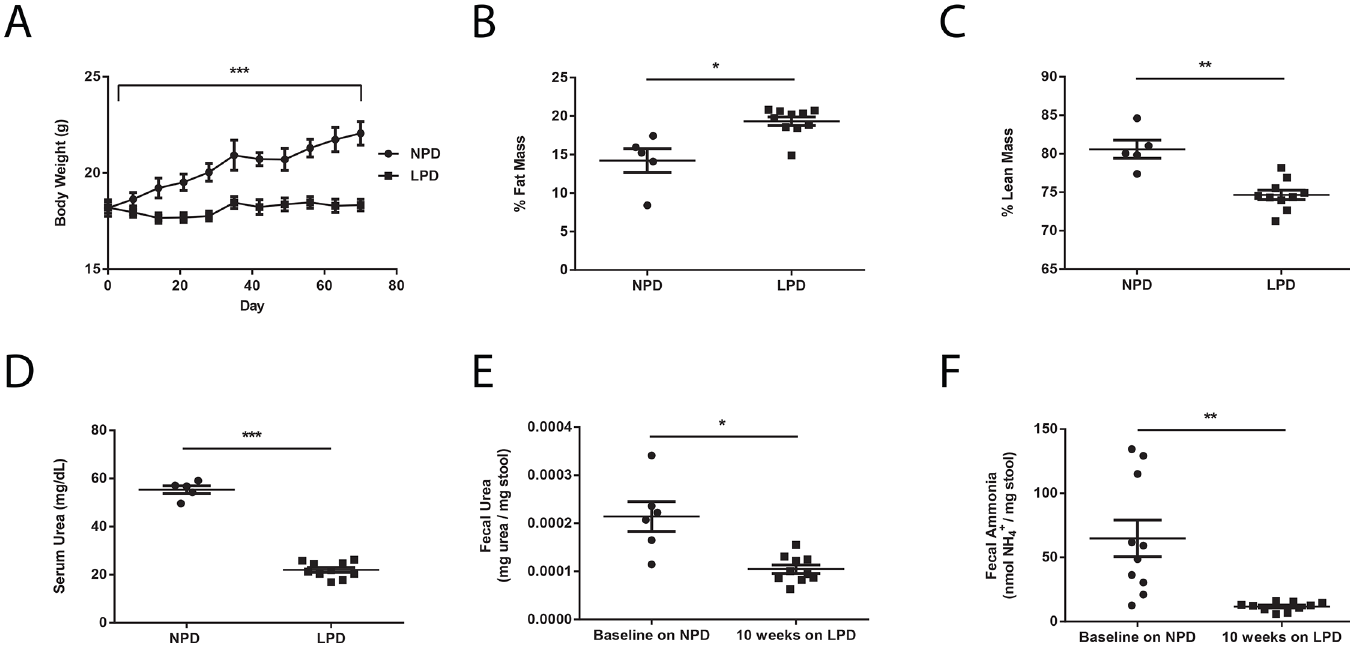
Fig 1. Changes in murine physiology and nitrogen metabolism on a LPD. Differences in (A) body weight (n = 5 in NPD group, n = 10 in LPD group), (B) % fat mass, (C) % lean mass, and (D) serum urea concentrations between NPD-fed and LPD-fed mice. (E) Fecal urea and (F) fecal ammonia levels at baseline on the NPD and after placement on the LPD. Values represent mean ± SEM. Statistical significance in body weight determined by two-way ANOVA with repeated measures; statistical significance in other parameters determined by paired and unpaired two-tailed Student ’ s t test. * p < 0.05, ** p < 0.01, *** p <